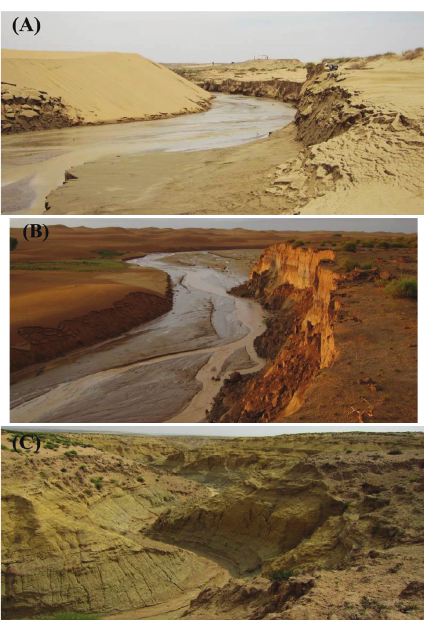
Figure 2: Surface characteristics of three reaches of the Sudalaer desert stream. (A)–(C) represent lower, middle, and upper reaches,